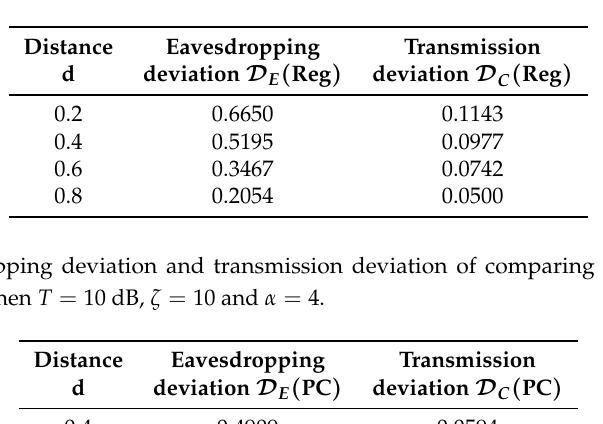
Table 3. Eavesdropping deviation and transmission deviation of comparing FJ-Reg scheme with Non-Jam scheme when T = 10 dB and α = 4.